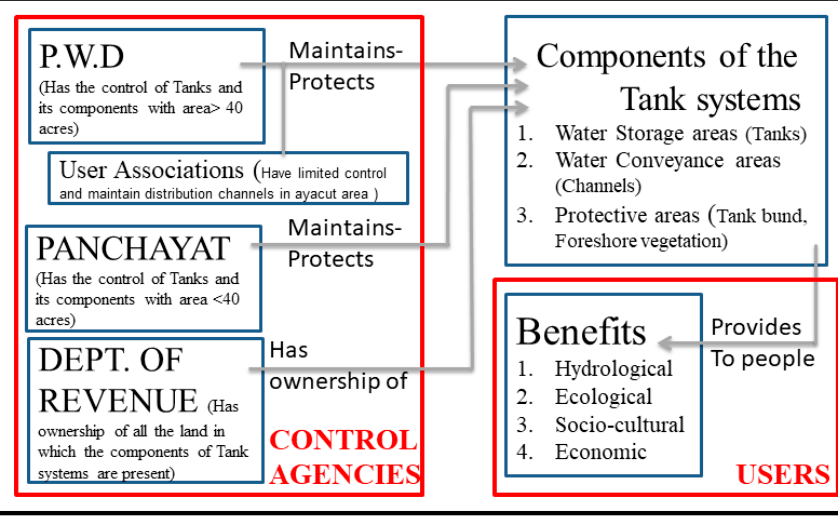
Figure 2. Present government management model of the Tank systems (Source—authors).